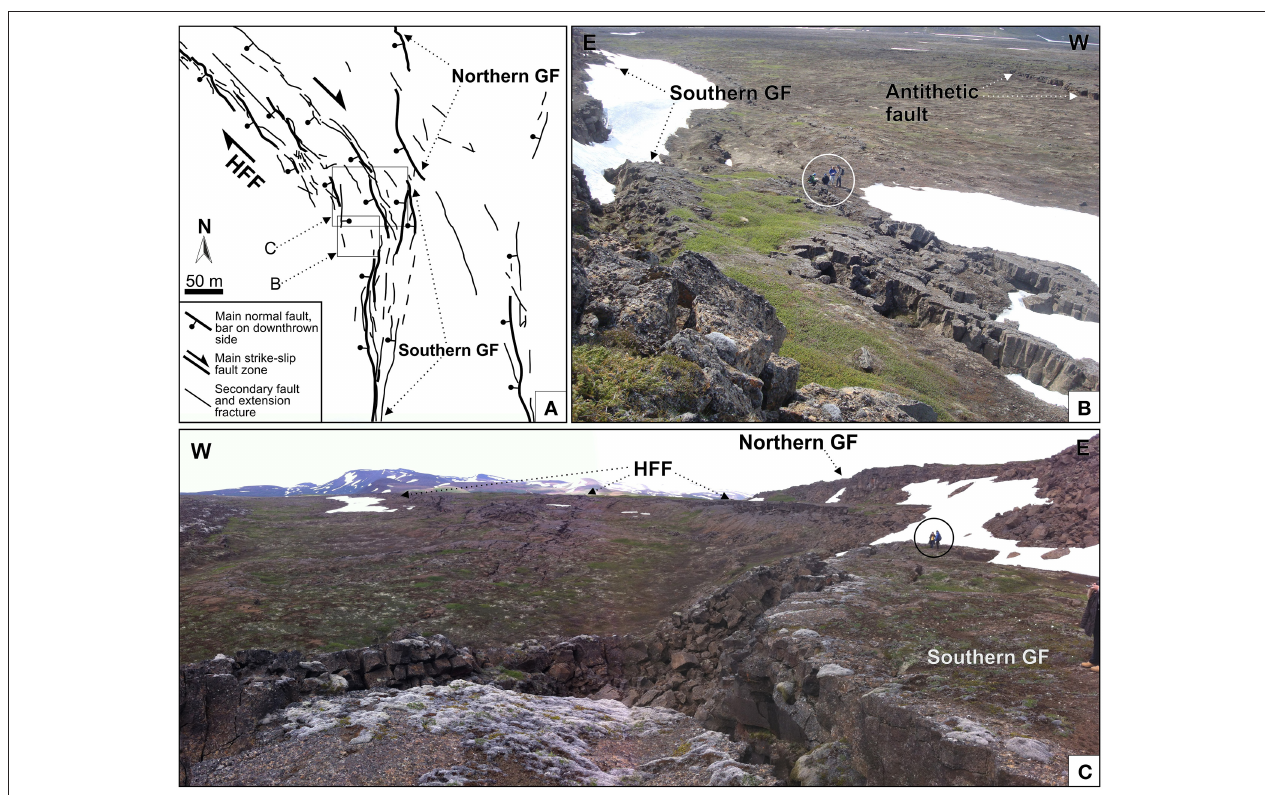
FIGURE 3 | (A) Detailed structural sketch map of the triple junction between the Husavik-Flatey Fault (HFF) and the Theystareykir Fissure Swarm (TFS). The HFF terminates against the westernmost fault of the TFS, known as Gudfinnugja Fault (GF) through a gradual bending and a splay of the fault plane that from an original NW–SE orientation attains a N–S strike. (B) Photo of the southern GF and its antithetic normal fault, looking south. Note men in circle for scale. Location in Figure 3A . (C) Photo of the junction zone between the HFF and the southern GF, looking north. Note men in circle for scale. Location in Figure 3A